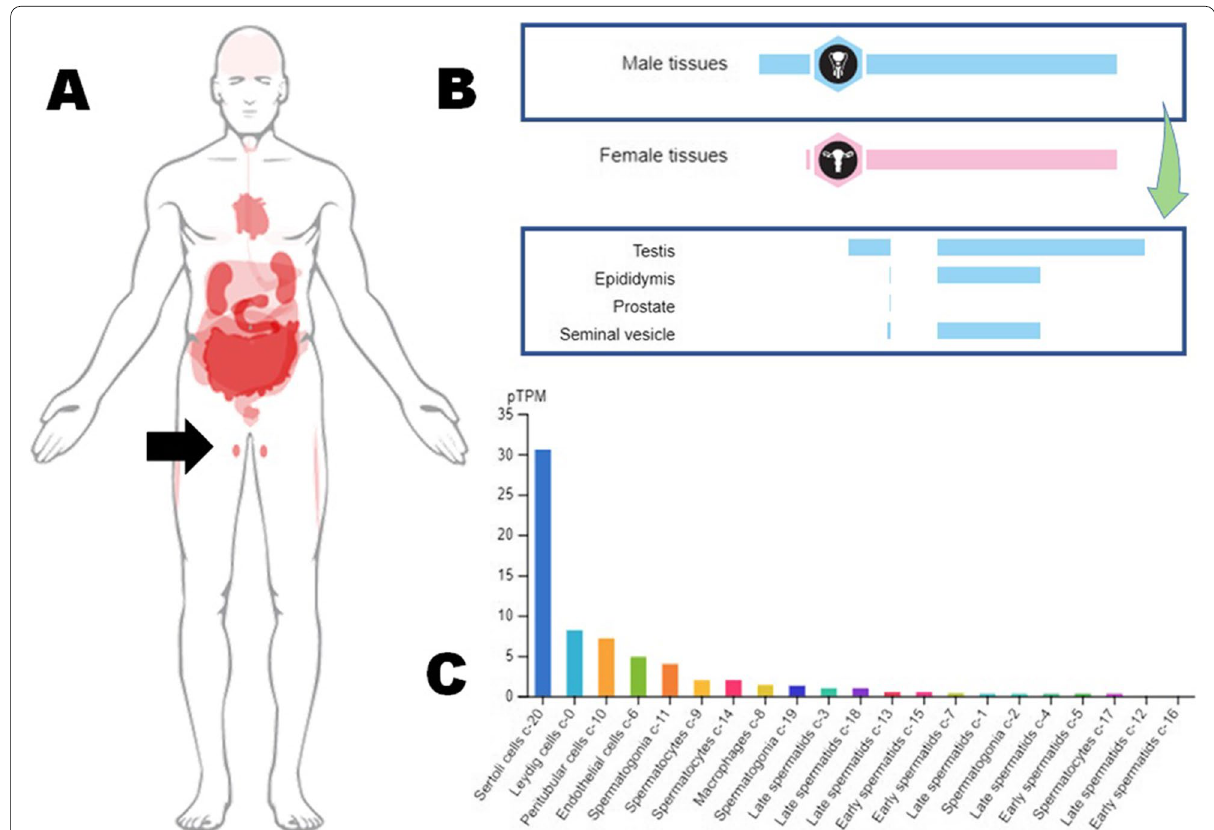
Fig. 1 Expressions of ACE2 in different systems ( A ), male reproductive organs ( B ), and testicular cells ( C ) [source: Human Protein Atlas,